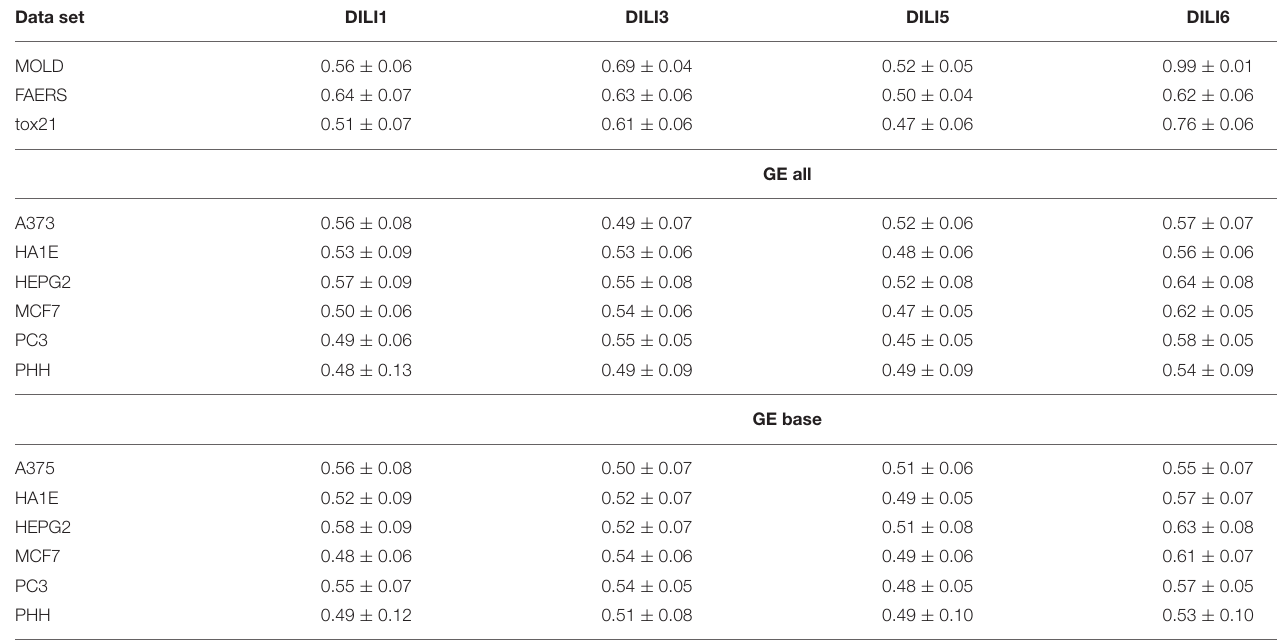
TABLE 3 | Results (AUC) of prediction for binary drug-induced liver injury (DILI) endpoints. Data